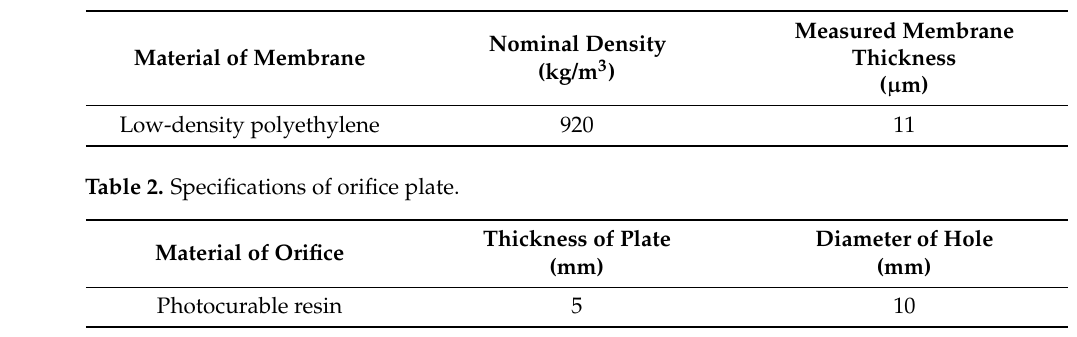
Figure 2. ( a ) Delay tube section of the interference silencer with incorporated zero-mass metamaterial; ( b ) dimensions of the delay tube. Table 1. Specifications of thin film material.